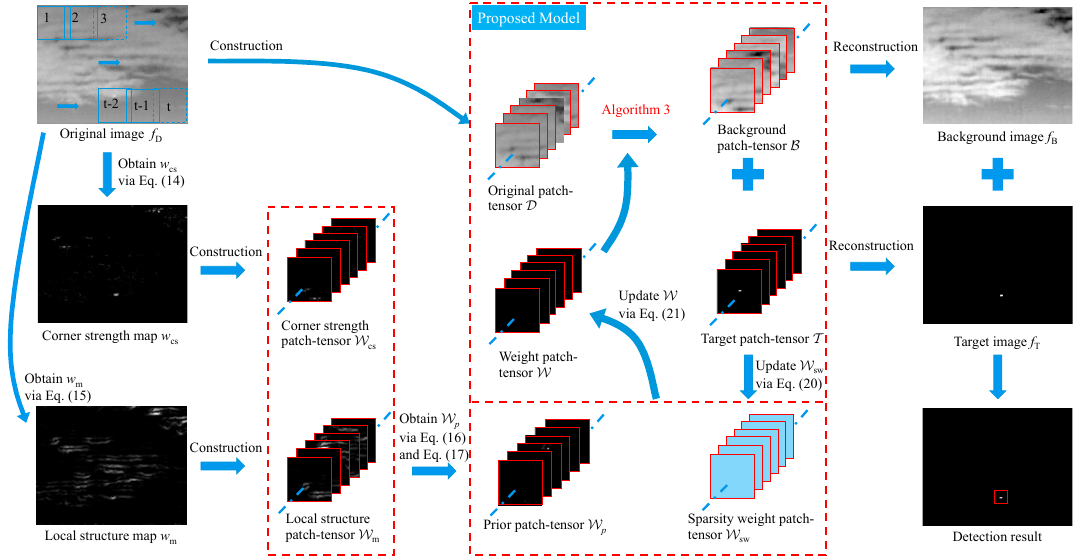
Figure 7. The overall procedure of the proposed model in this paper.